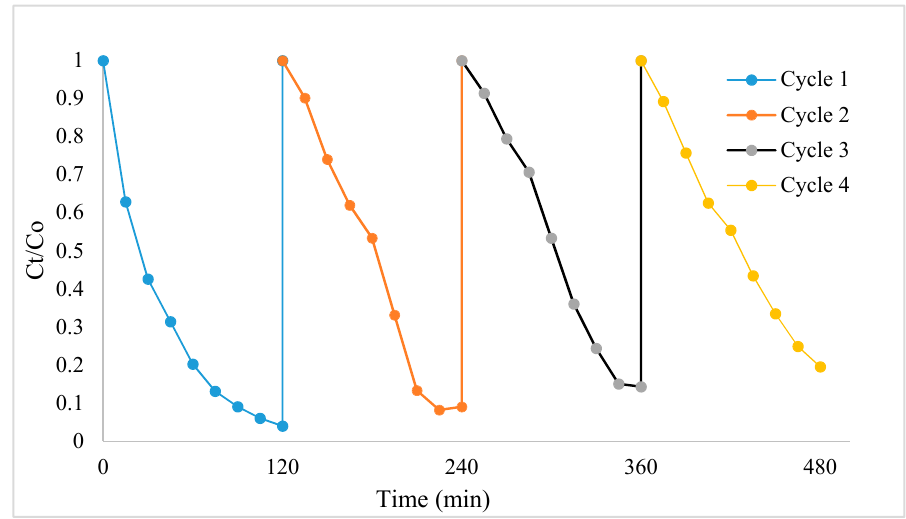
Figure 9. Reusability cycles of MO degradation using t Ce 2 O 3 /BiVO 4 /rGO nanocomposite and a solution of 5 mg/L dye.